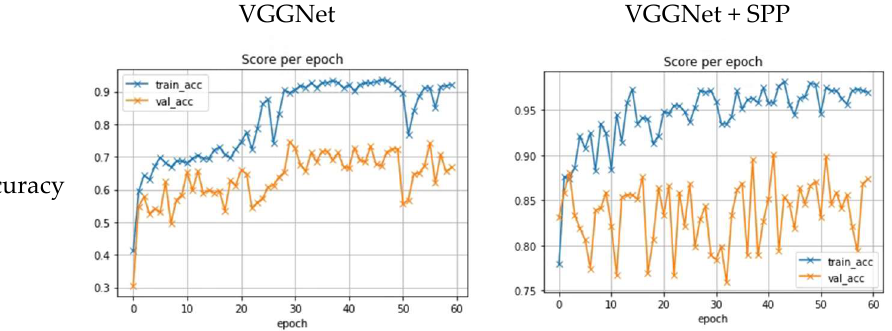
Figure 12. Performance comparison analysis between VGGNet and VGGNet + SPP.